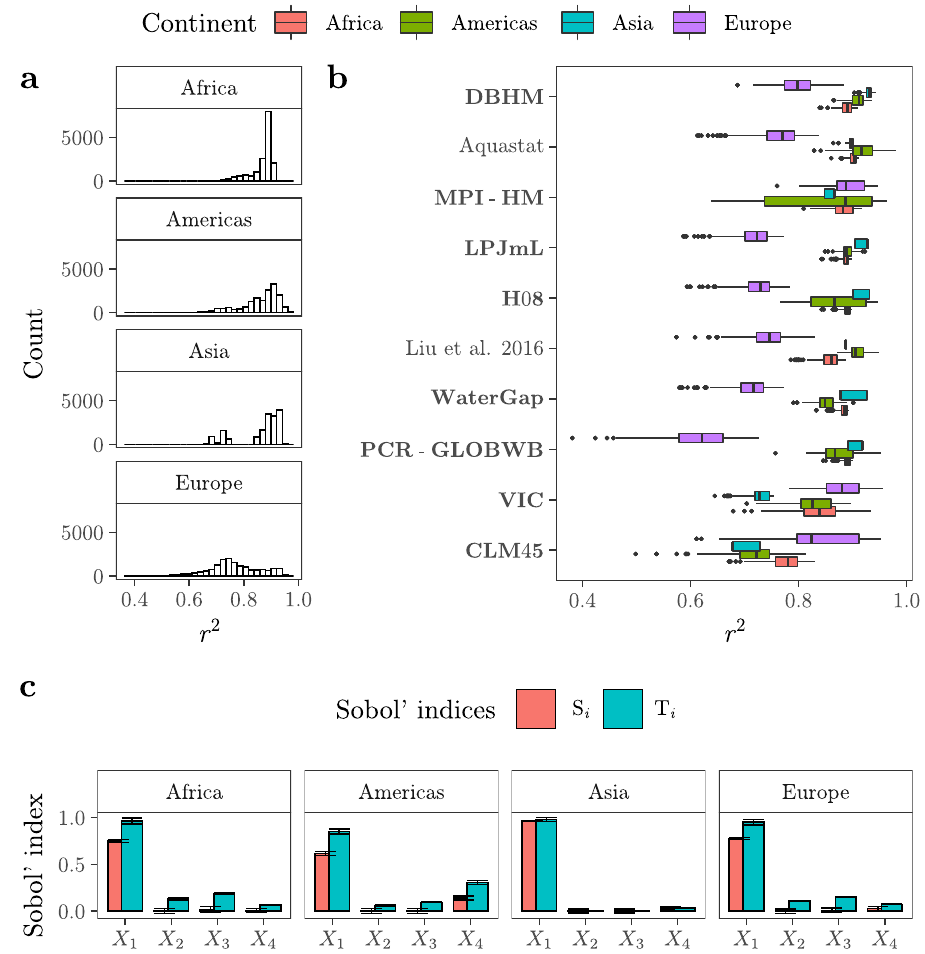
Fig. 2 Uncertainty and sensitivity analysis. a Empirical distribution of r 2 at the continental level. b Boxplots of r 2 values yielded by each GM (in bold) and FAO-based dataset (centre line, median; box limits, upper and lower quartiles; whiskers, 1.5x interquartile range; points, outliers). c Sobol' indices. S i and T i refer respectively to Sobol' fi rst and total order indices. S i measures the in fl uence of a parameter in the model output ( r 2 in this case), while T i measures the in fl uence of a parameter jointly with its interactions. The bars re fl ect the mean value and the error bars display the 95% con fi dence intervals, computed with the normal method after bootstrapping ( R =